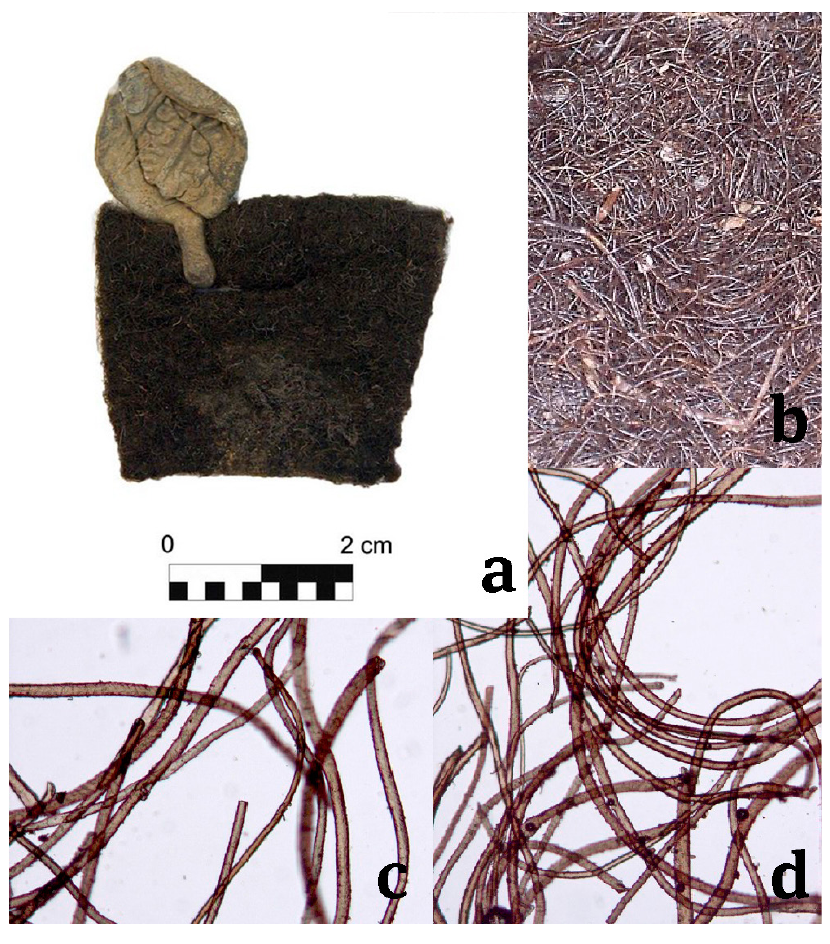
Figure 22. Remnants of fabric of the seal from Leszno: a – seal; b – the fabric shown in x150 magnification (microscope Zeiss SteREO); c and d – the fibres shown in x500 magnification (microscope Zeiss Axio Scope